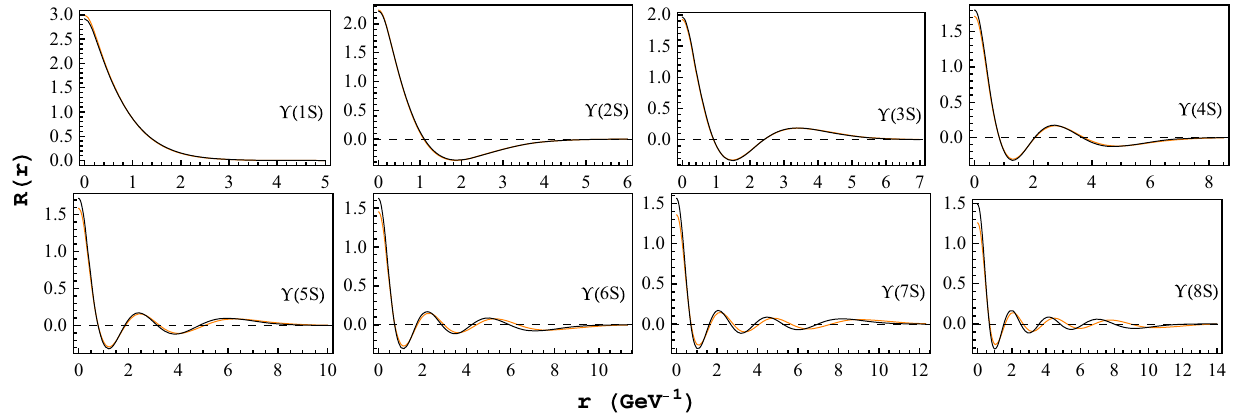
Fig. 3 The radial wave functions of the S -wave ϒ( nS ) state in the position space, which includes radial quantum number from one to eight. The orange and black curves represent the results from our modified GI model and GI model,